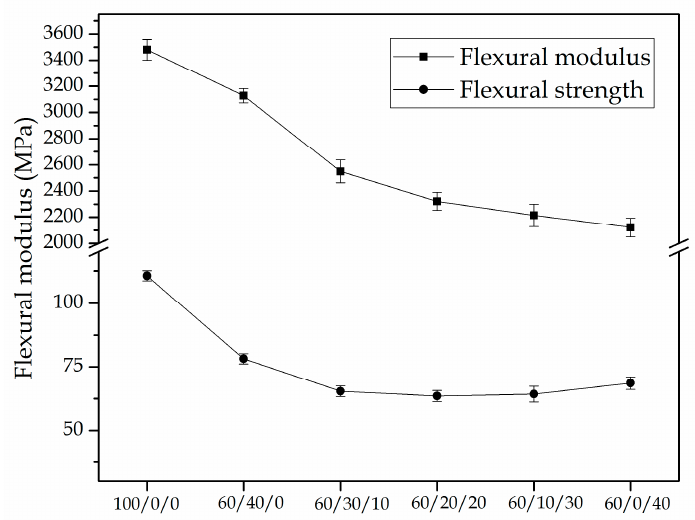
Figure 2. Plot evolution of mechanical flexural properties of PLA/PHB/PCL ternary blends as a function of their composition (wt % PLA/wt % PHB/wt % PCL).